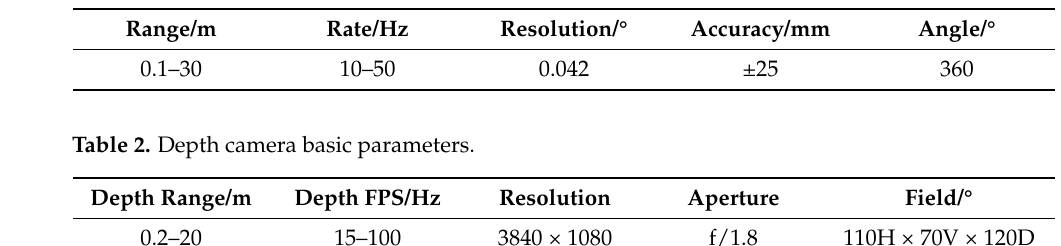
Table 1. 2D LRF basic parameters.